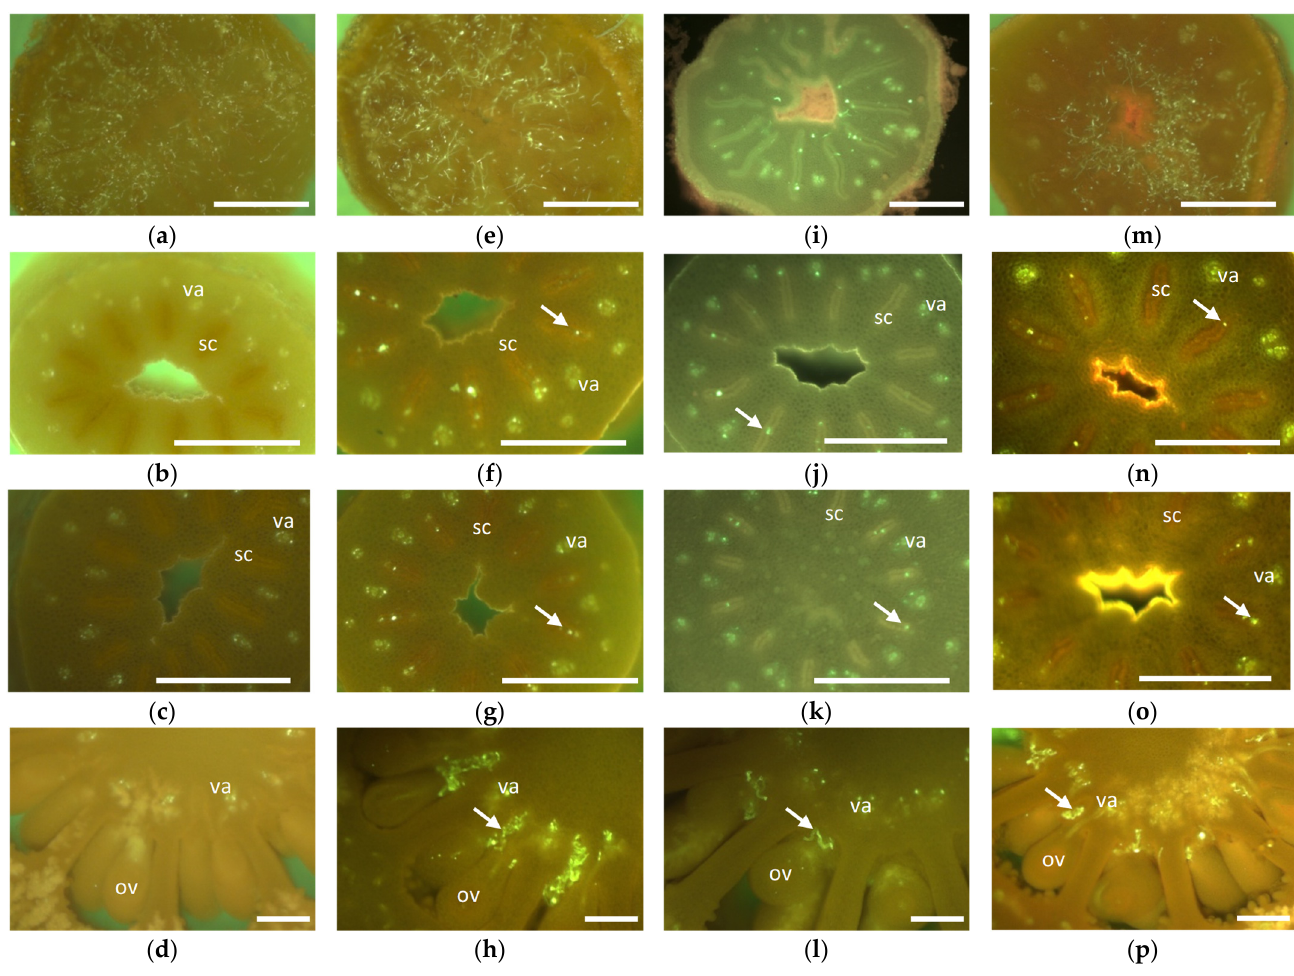
Figure 2. Histological sections of ‘Fortune’ mandarin pistils. ( a – d ) Self-pollinated pistils under field conditions. ( e – h ) Cross-pollinated pistils under field conditions. ( i – l ) Cross-pollinated pistils at 10 °C. ( m – p ) Cross-pollinated pistils at 30 °C. The pollen from ‘Clemenules’ clementine was used for cross-pollinations. Pollen tubes are marked by an arrow; va: vascular axis; sc: stylar canal; ov: ovule. Scale bars are depicted by white lines: ( a , e , i , m ) 1 mm; ( b , c , f , g , j , k , n , o ) 0.5 mm; ( d , h , l , p ) 0.2 mm.